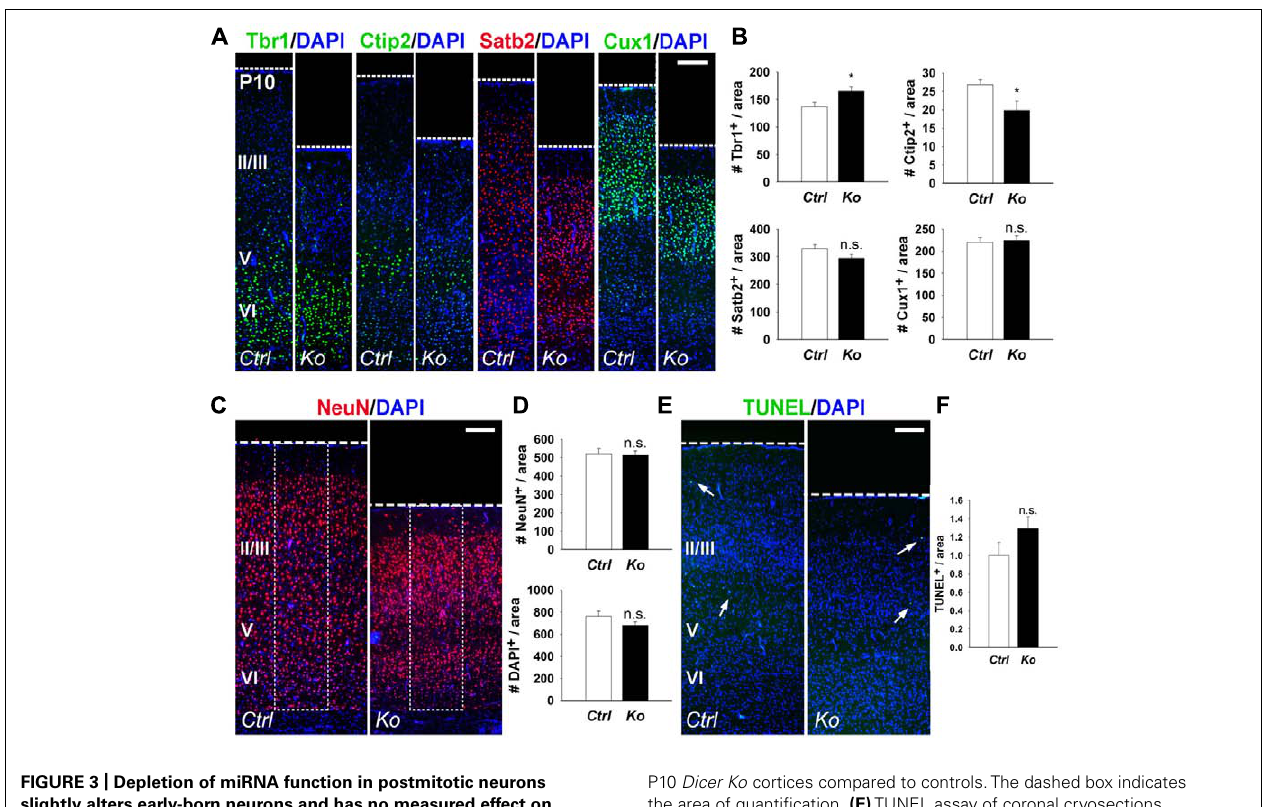
FIGURE 3 | Depletion of miRNA function in postmitotic neurons slightly alters early-born neurons and has no measured effect on neuronal production and cell death at P10. (A,B) The numbers of early-born neurons labeled withTbr1 were increased and Ctip2 were decreased in P10 Nex-Cre-Dicer Ko ( Ko ) cortices, compared to controls ( Ctrl ). The numbers of late-born neurons labeled with Satb2 and Cux1 were unaffected in P10 Dicer Ko cortices, compared to controls. (C,D) Numbers of NeuN + and DAPI + cells were unaffected in the cortical wall of